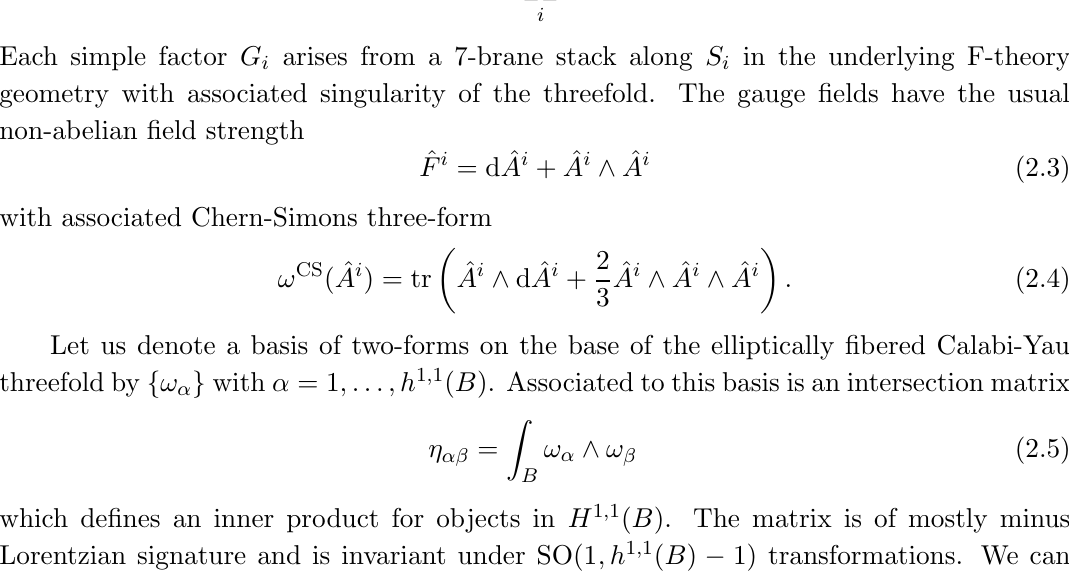
Figure 1 . The 7-branes (green) wrap the discriminant locus (cid:1) = 0 dimensions R S 1 M (cid:0) . The D3-brane (blue) wraps the curve C (cid:2) (cid:2) where [(cid:1) 0 ] is associated to singularities of the (cid:12)bration which render the total